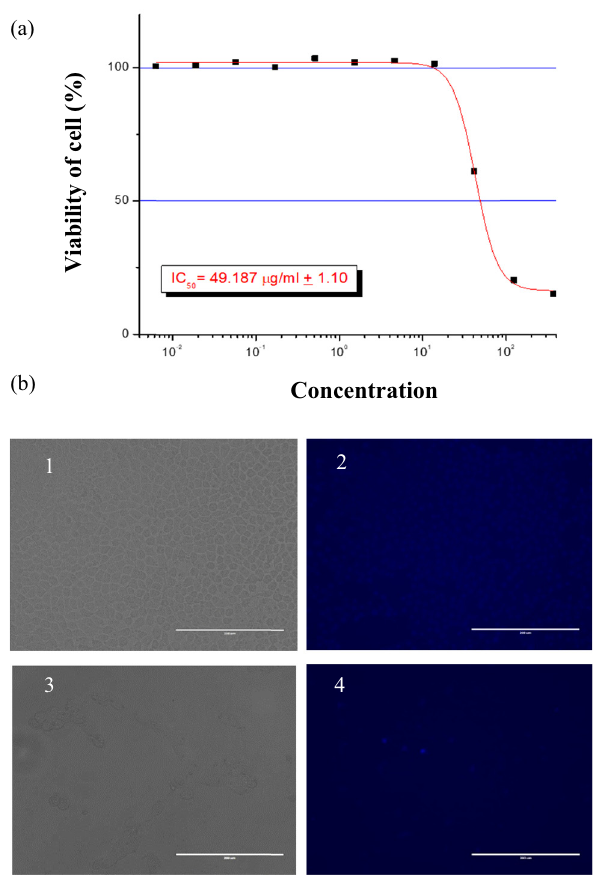
Figure 3: Cytotoxicity of MFC extract on HUVEC lines. ( a ) Values are mean values of three experiments. ( b ) Light and fl uorescent photomicrographs ( 20 ×) of ( 1 ) control and ( 2 ) MFC extract ( 123.4 µg/mL )- treated cells for 24 h. ( 3 ) Untreated and ( 4 ) treated cells stained with Hoechst 33,342 to show condensed DNA. Scale bars: XX μ